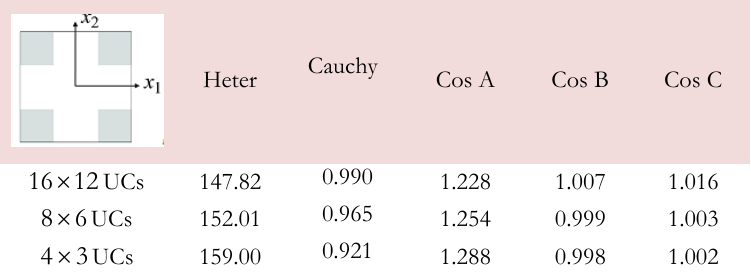
Table 1: Structural stiffness in the case of different assemblages of UC1: Heter = micromechanical model; Cauchy= homogenized first order model; Cos A = homogenized Cosserat with Procedure A ; Cos B = homogenized Cosserat with Procedure B ; Cos C = homogenized Cosserat with Procedure C .